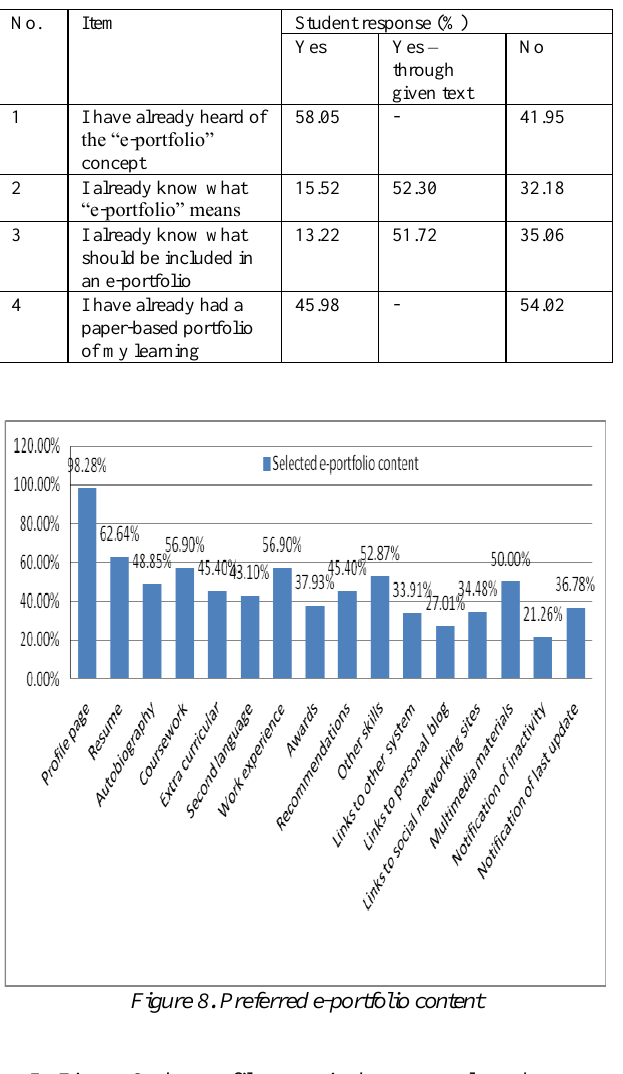
Table 3. Prior knowledge and experience of e-portfolios